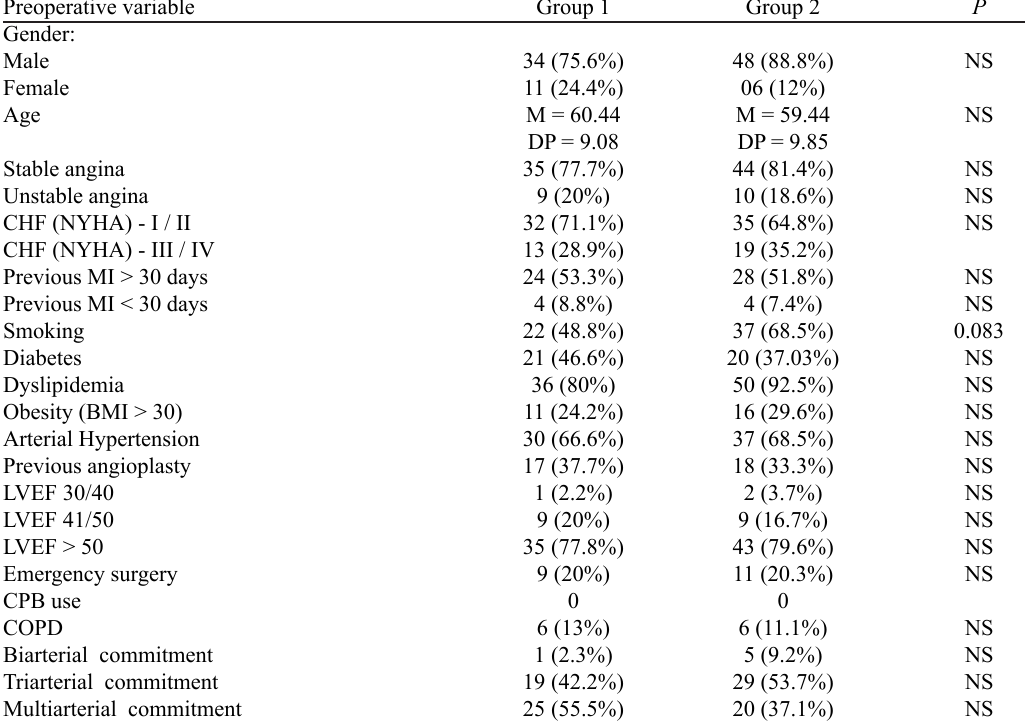
Table 1. Variables analyzed in the preoperative